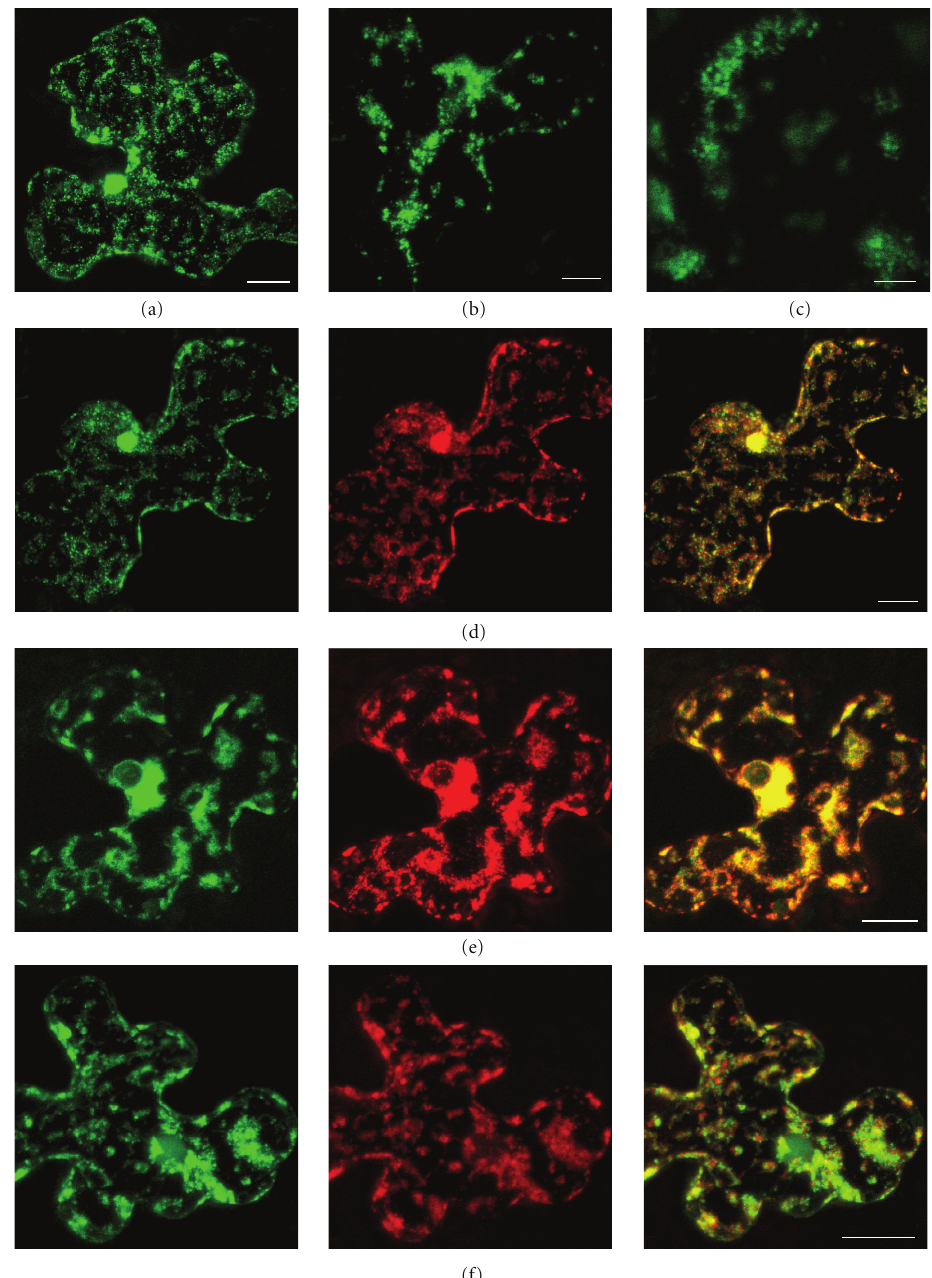
Figure 3: Co-expression of 18KIId8 and its fusions with the ER and Golgi markers in bombarded epidermal cells of N. benthamiana leaves. (a)–(c) GFP-18KIId8. (d) ST-YFP + GFP-18KIId8. (e) m-GFP5-ER + YFP-18KIId8. (f) m-GFP5-ER + ST-YFP + 18KIId8. In (d)–(f), GFP signal is shown in the left panels, YFP signal—in the middle panels, and merged images—in the right panels. All images except (c) are reconstructed by superposition of series of confocal optical sections. (c) represents a single optical section in a cell peripheral region. Scale bar: 20 μ m in (a), (d)–(f); 10 μ m in (b); 4 μ m in